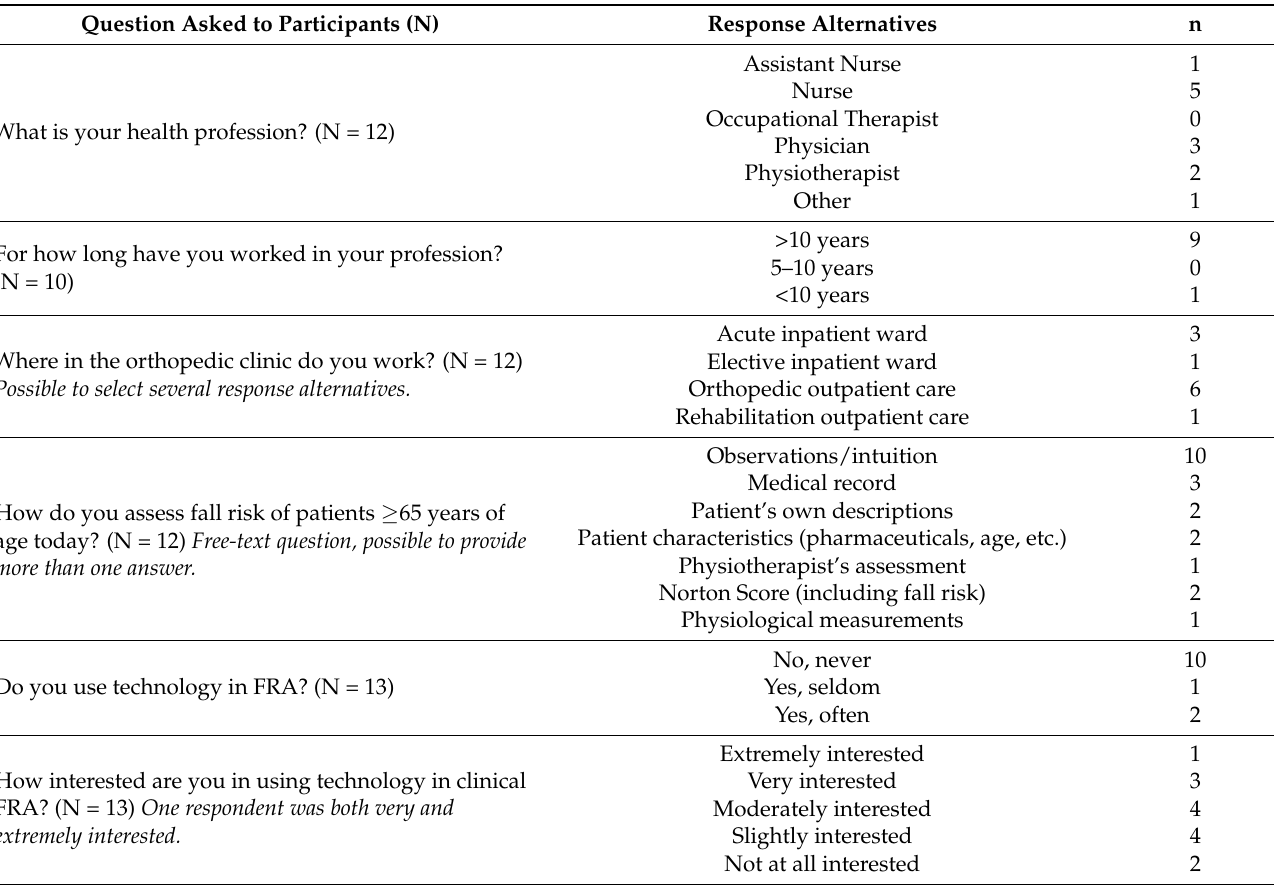
Table 3. Background characteristics of participants in sub-study 4. For each question, the total number of responses (N), the response alternatives, and the number of responses per response alternative (n) are